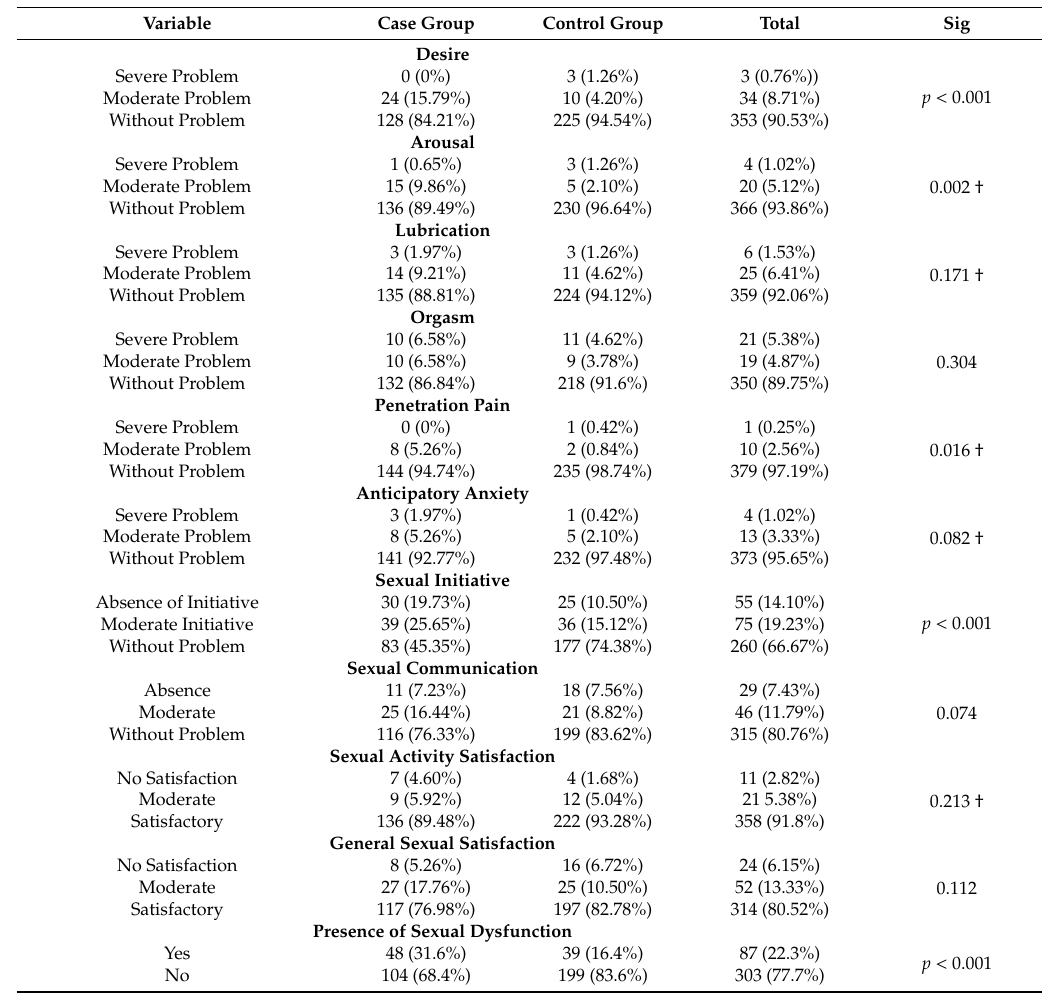
Table 2. Sexual function scores in case and control groups.